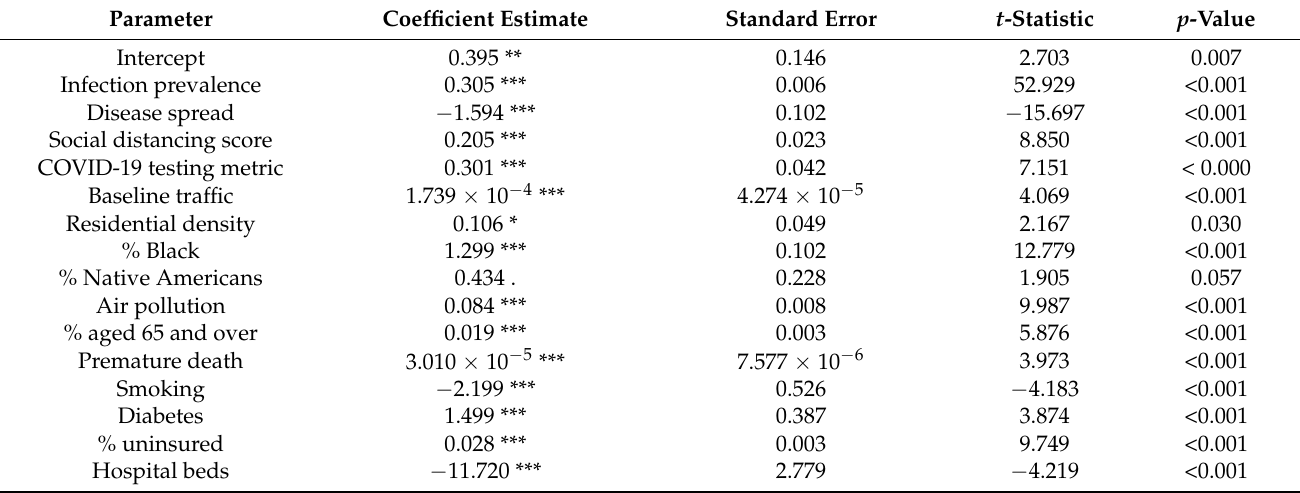
Table 3. Parameter estimates of the global OLS model.